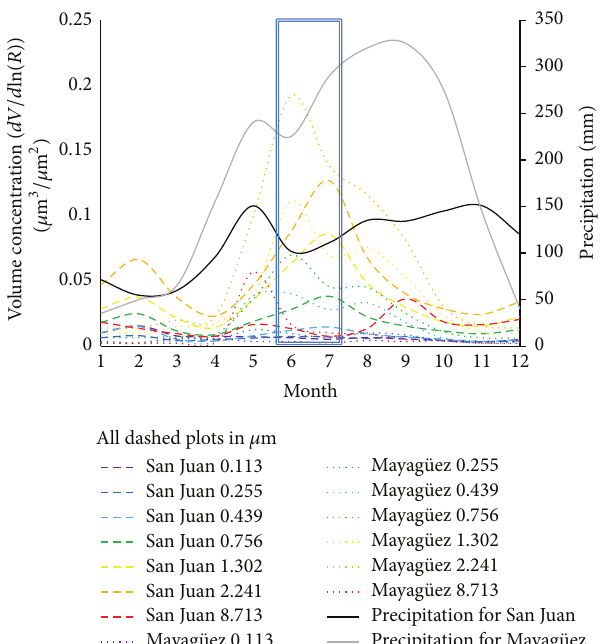
Figure 1: Monthly precipitation climatology (1979–2014) and AERONET aerosol volume concentration for various radii at Mayag¨uez (2012–2015) and at San Juan (2005–2015). Solid lines represent precipitation for Mayag¨uez (grey) and San Juan (black). Short-dashed plots represent aerosol data for Mayag¨uez; long- dashed plots represent aerosol data for San Juan. Rectangular box encloses the MSD. The precipitation climatology (solid lines) is shown along with available aerosol particle size distribution (PSD) data (dashed